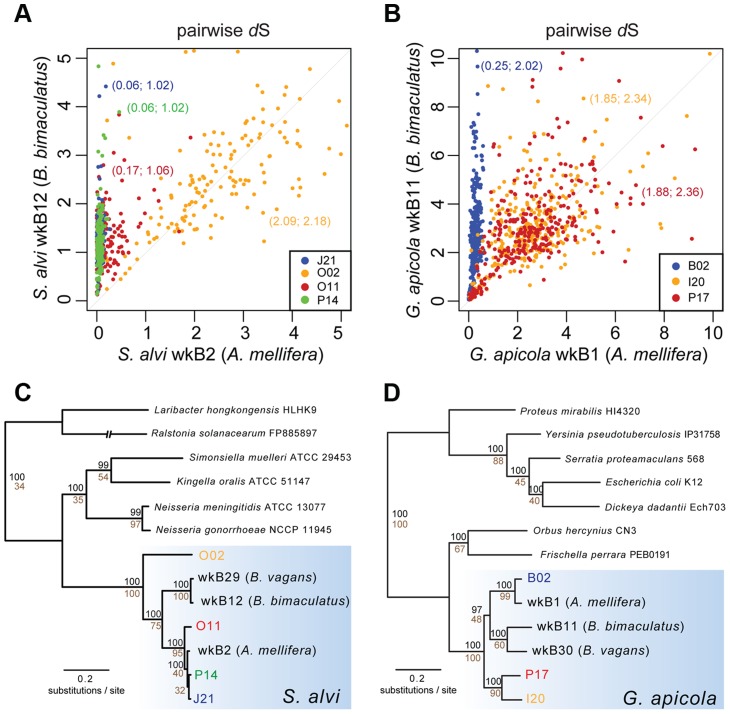
Sequence divergence and phylogenetic analysis of protein-encoding genes of (A and C) S. alvi SAGs and (B and D) G. apicola SAGs.Pairwise sequence divergence was measured by estimated rates of synonymous substitutions per site (dS) for (A) 226 orthologs of S. alvi and (B) 348 orthologs of G. apicola. Pairwise dS values of SAGs and reference genomes of A. mellifera isolates (in (A), S. alvi wkB2; in (B), G. apicola wkB1) are plotted on the x-axes. Pairwise dS values of SAGs and reference genomes of bumble bee (Bombus bimaculatus) isolates (in (A), S. alvi wkB12; in (B), G. apicola wkB11) are plotted on the y-axes. Mean dS values are given in parentheses (SAG compared to A. mellifera isolate; SAG compared to B. bimaculatus isolate). For visualization purposes, genes with unrealistically high dS values were excluded from representation. Complete data is presented in Figure S5. Note that genes with dS value ≥3 can be considered at or near saturation due to the four possible bases in the genetic code. (C and D) Maximum likelihood trees based on the concatenated alignments of 114 and 211 conserved orthologs of S. alvi and G. apicola, respectively. Values above branches represent bootstrap values ≥80 for 100 replicates. Values below branches indicate the percentage of single-gene trees with congruent topology at this node.